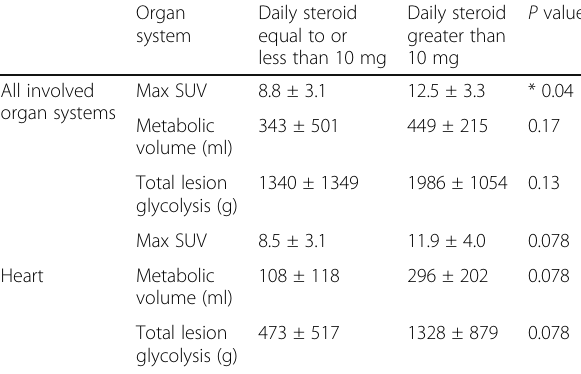
Table 2 Differences in semi-quantitative values for all involved organ systems including the heart and for those of the heart alone between patients with daily oral steroid dose of less or equal to 10 mg and greater than 10 mg. * represents statistically